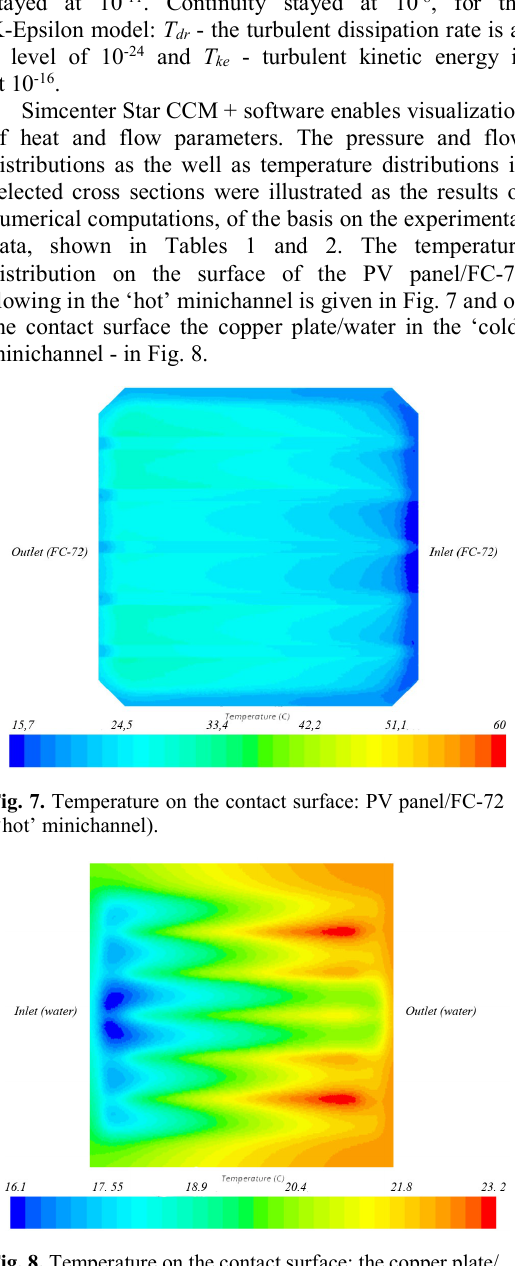
Fig. 8. Temperature on the contact surface: the copper plate/ distilled water (‘cold’ minichannel).